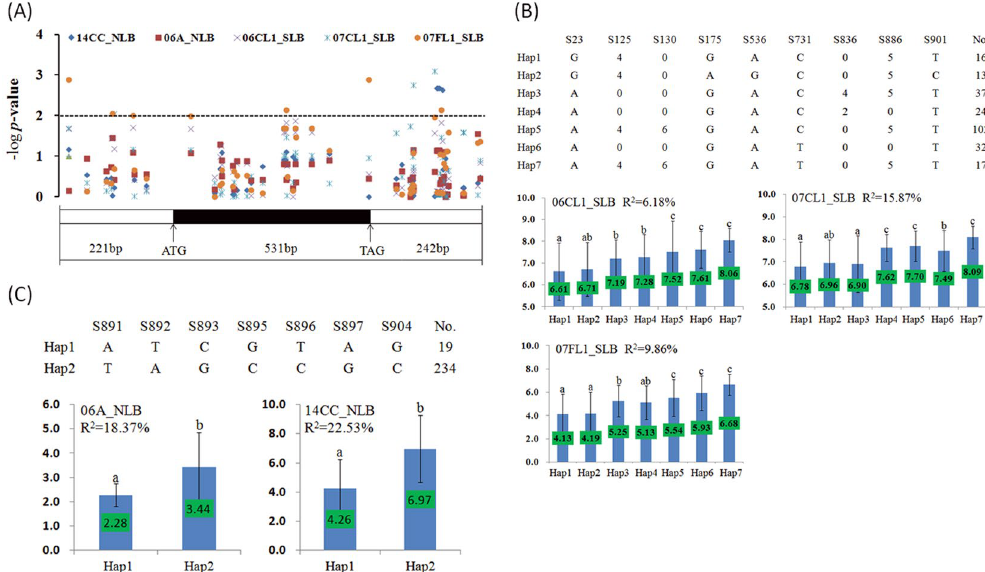
Figure 6. Association between polymorphisms in GRMZM2G441903 and SLB and NLB resistance ( A ) as well as the phenotypic comparisons of different haplotypes ( B , C ) in different environments (14CC_NLB, 06A_NLB, 06CL1_SLB, 07CL1_SLB, 07FL1_SLB). All polymorphic sites within the sequenced region with an MAF > 0.05 were used. The y axis represents the –log P-value obtained via MLM analysis for the association panel (A). Different letters indicate statistically significant differences ( P < 0.05) according to multiple comparison analyses ( B ). According to the associated sites, the association panel was divided into seven haplotypes for SLB ( B ) and two haplotypes for NLB ( C ). The genetic contribution of haplotype was estimated using a general linear model (GLM). The averaged disease score is indicated on the middle bar for each kind of